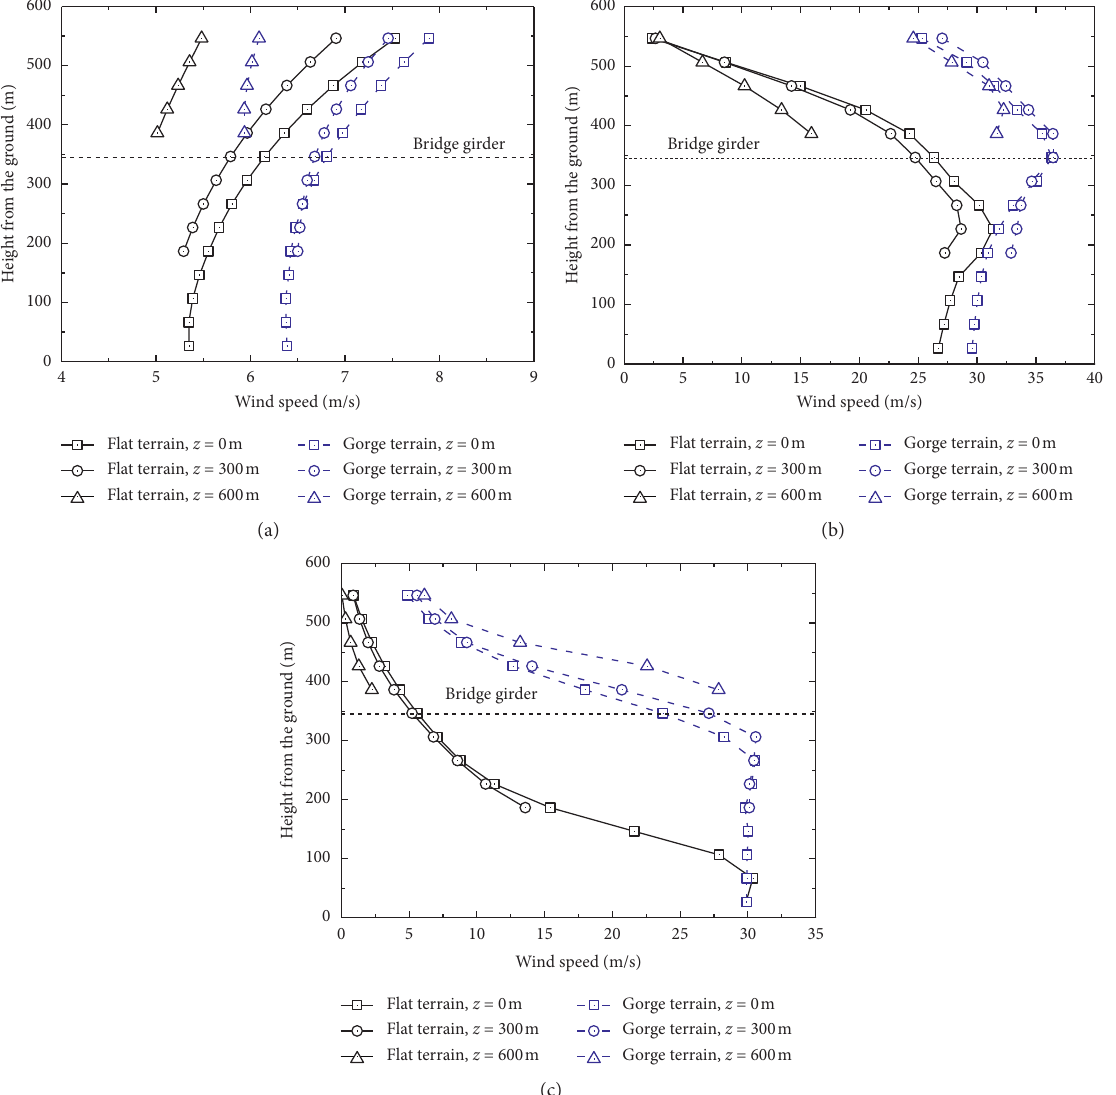
Figure 10: Distributions of vertical profile of horizontal wind speed in flat and gorge terrains at the three typical time. (a) t � 50s. (b) t � 100s. (c) t �